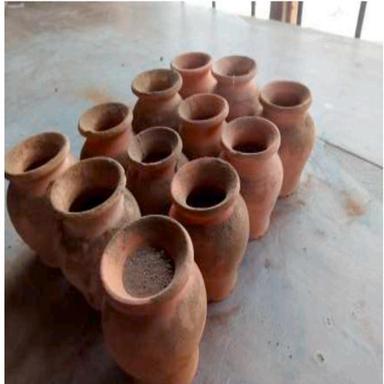
The location of the LOD within the Benue trough. Fig. 2. The prepared samples placed in unique clay pots for firing.